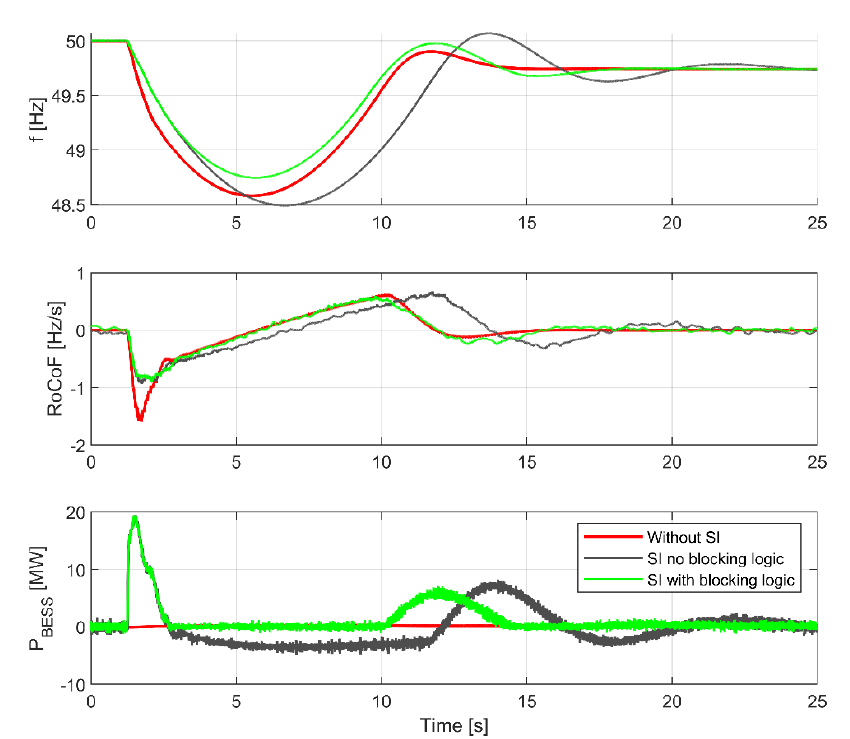
Figure 12. Comparison of responses to 40 MW trip: with no synthetic inertia support (blue), with SI support without blocking logic (black) and with SI with blocking logic (green).